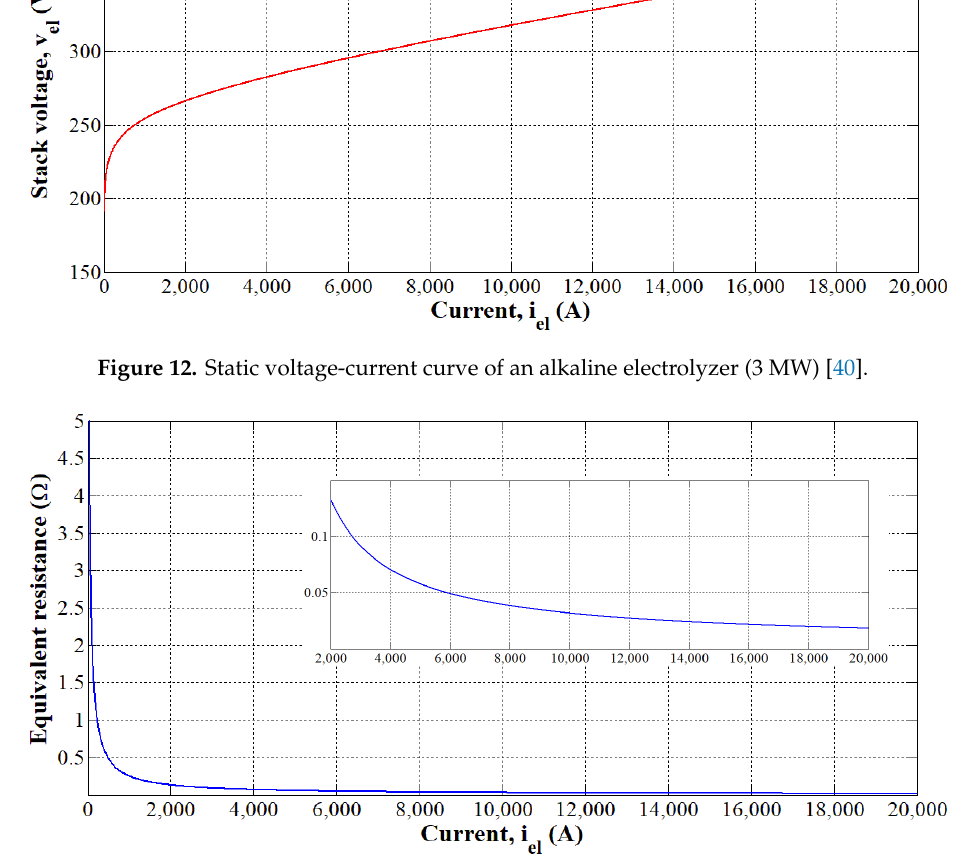
Figure 13. Equivalent resistive load according to the current [40].